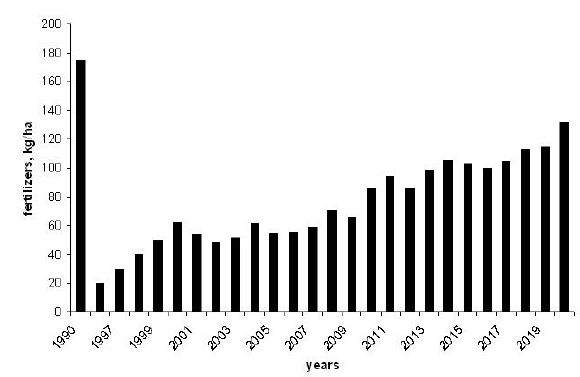
Figure 1 . Application of mineral fertilizers to agricultural fields of the Orel